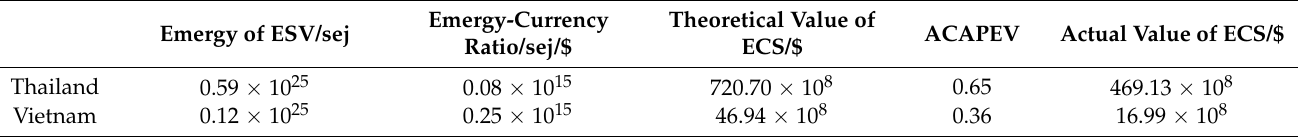
Table 8. Ecological compensation standard (ECS) for consumer countries of ecological services. Emergy-Currency Theoretical Value of Emergy of ESV/sej ACAPEV Actual Value of Ratio/sej/$ ECS/$